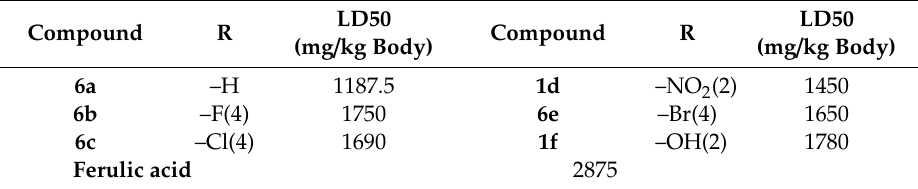
Table 2. Lethal dose 50 (LD50 in mg / kg body) for azetidine-2-one derivatives.